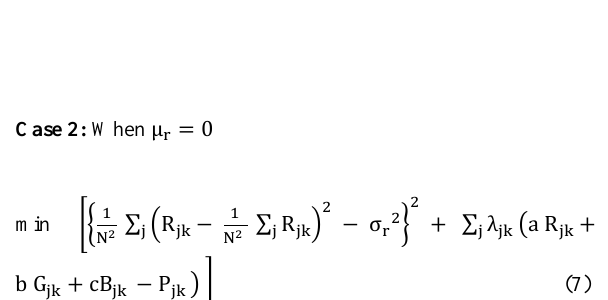
Figure 2. 4 × 4 pixels multispectral